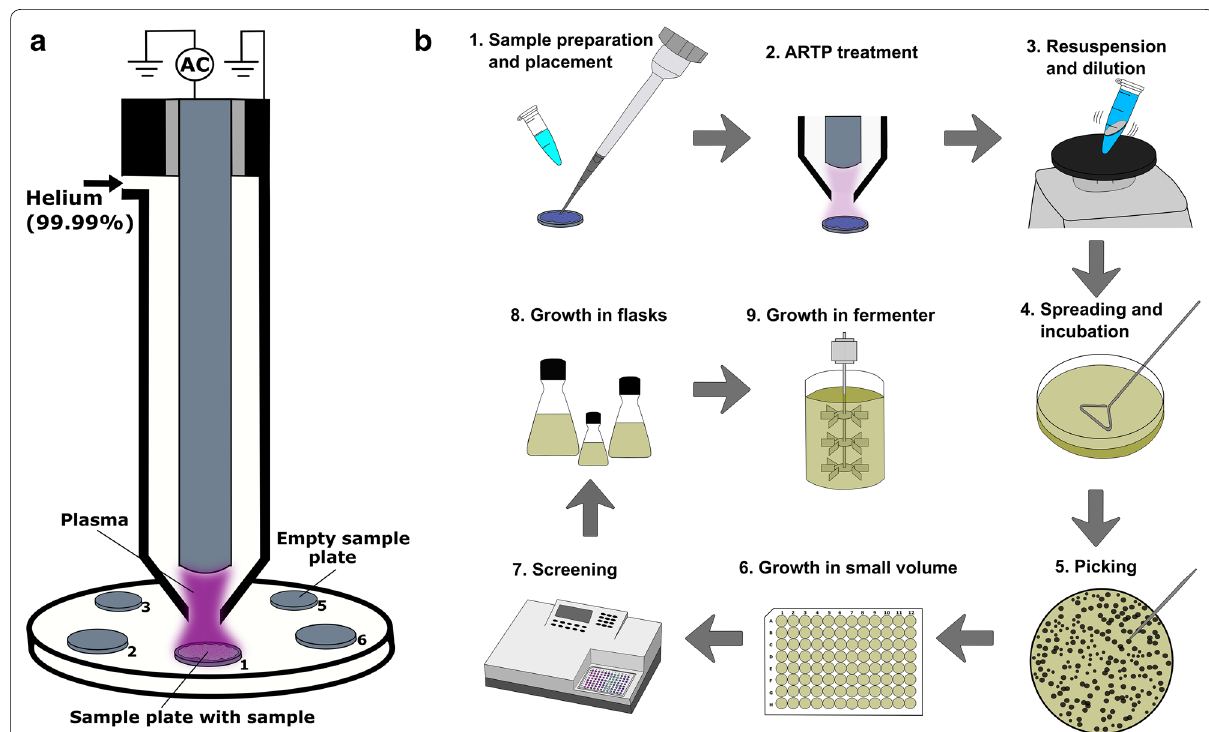
Fig. 1 a RF APGD plasma jet generator as the core component of the ARTP system treating a microbial sample (adapted from Zhang et al. 2014). b Typical sequence of an ARTP mutagenesis